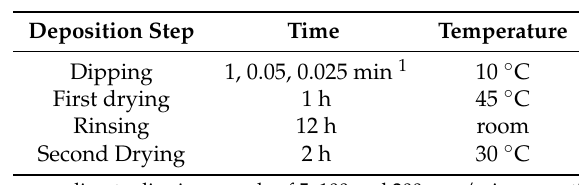
Table 2. Fabrication step details of the deposition procedure with the optimized dipping